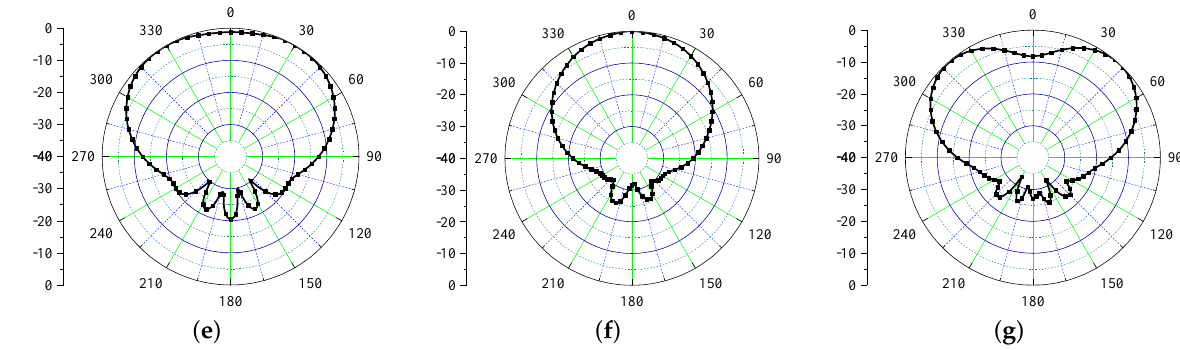
Figure 9. Simulated radiation patterns of Iteration 2 design (xz plane) at ( a ) 868 MHz ( b ) 3 GHz ( c ) 3.5 GHz ( d ) 4 GHz ( e ) 4.5 GHz ( f ) 5 GHz.